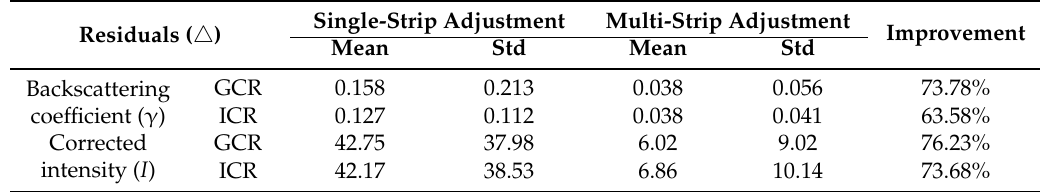
Table 2. Improvement rates of the proposed methods.